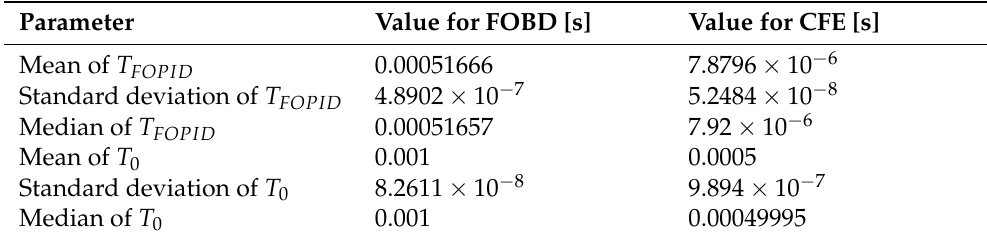
Table 7. Comparison of real-time parameters for both methods. T FOPID denotes the duration of control signal computing, and T 0 is the assumed sample